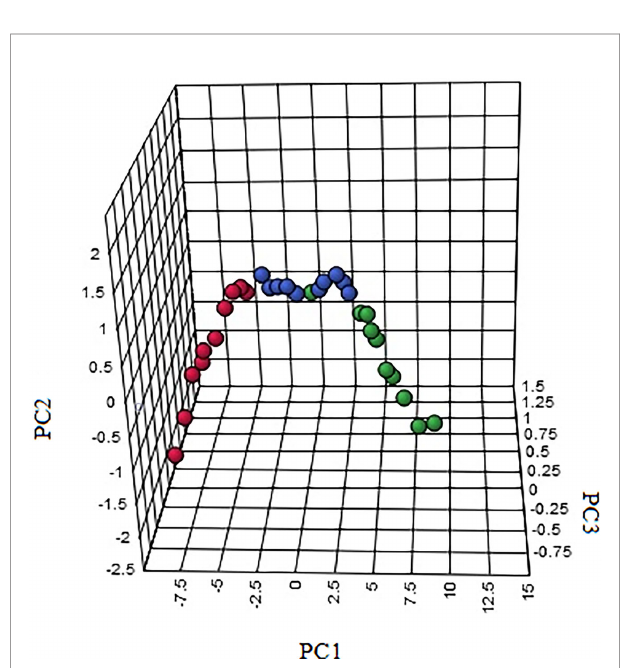
FIGURE 8 | The 3-D PCA score plot of control, model, and HNK-treated groups in urine metabolism pro fi le. M, model group. The red dot indicates the control group, the green dot indicates the model group, and the blue dot indicates the treatment